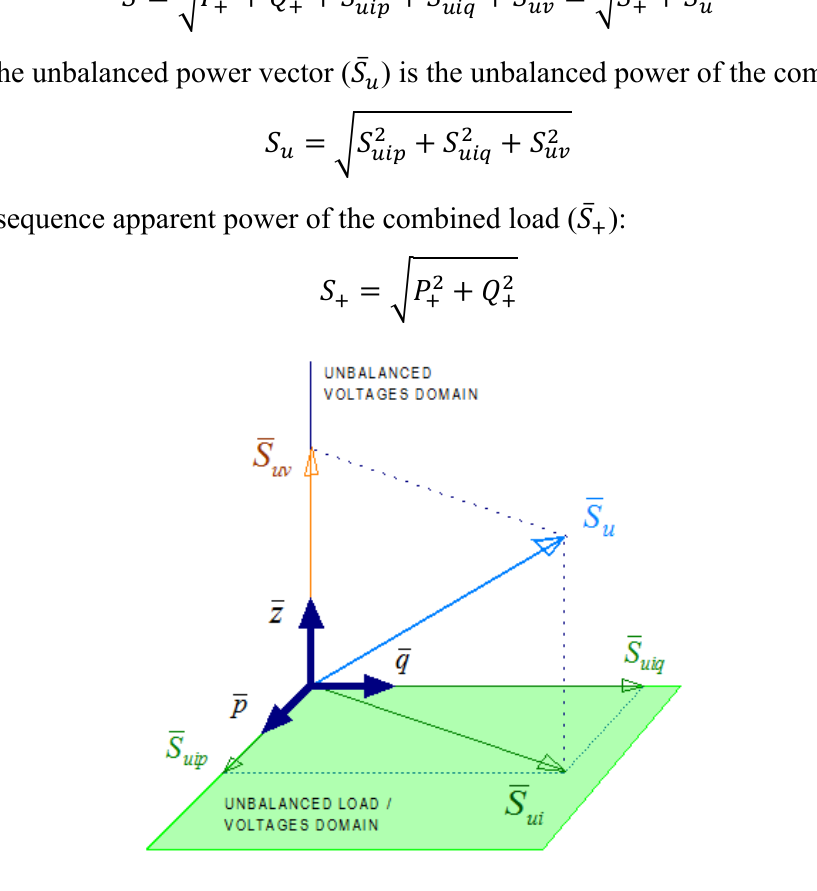
Figure 4. Representation of the unified power measurement (UPM) unbalanced power vector and its